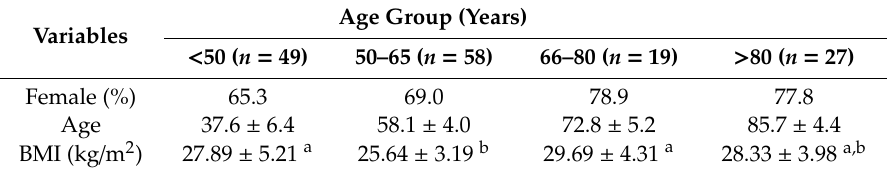
Table 1. General characteristics of subjects according to age groups.